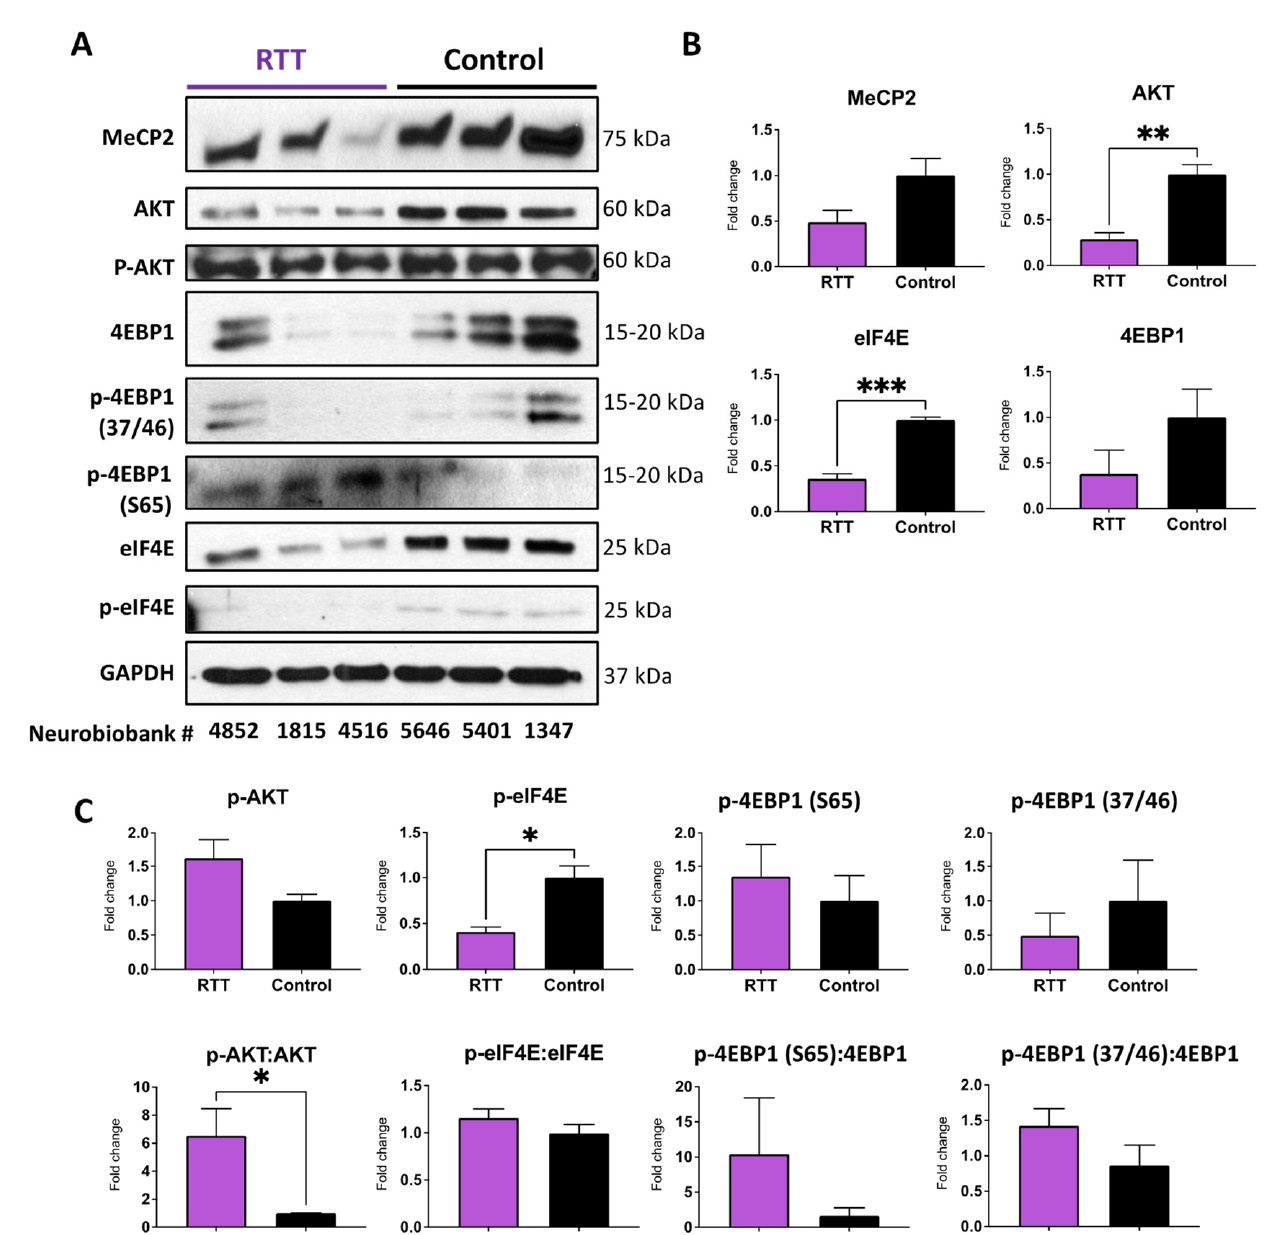
Figure 11. Protein analysis of indicated proteins in the brain of Rett Syndrome patients and non-Rett Syndrome controls. ( A ) Western blot analysis of the indicated proteins in the post-mortem human brain tissues (frontal cerebrum) compared with controls. The NIH NeuroBioBank ID of the samples are provided below the Western blot images. For detailed information about these samples, please refer to Table 4. ( B ) Quantification of the indicated total proteins from A. n = 3, and data are reported as mean ± SEM. ( C ) Quantification of the indicated phosphorylated proteins from A, as well as the ratio analysis of the phosphorylated proteins from A versus their own non-phosphorylated pan proteins, *: p < 0.05, **: p < 0.01, ***: p < 0.001.